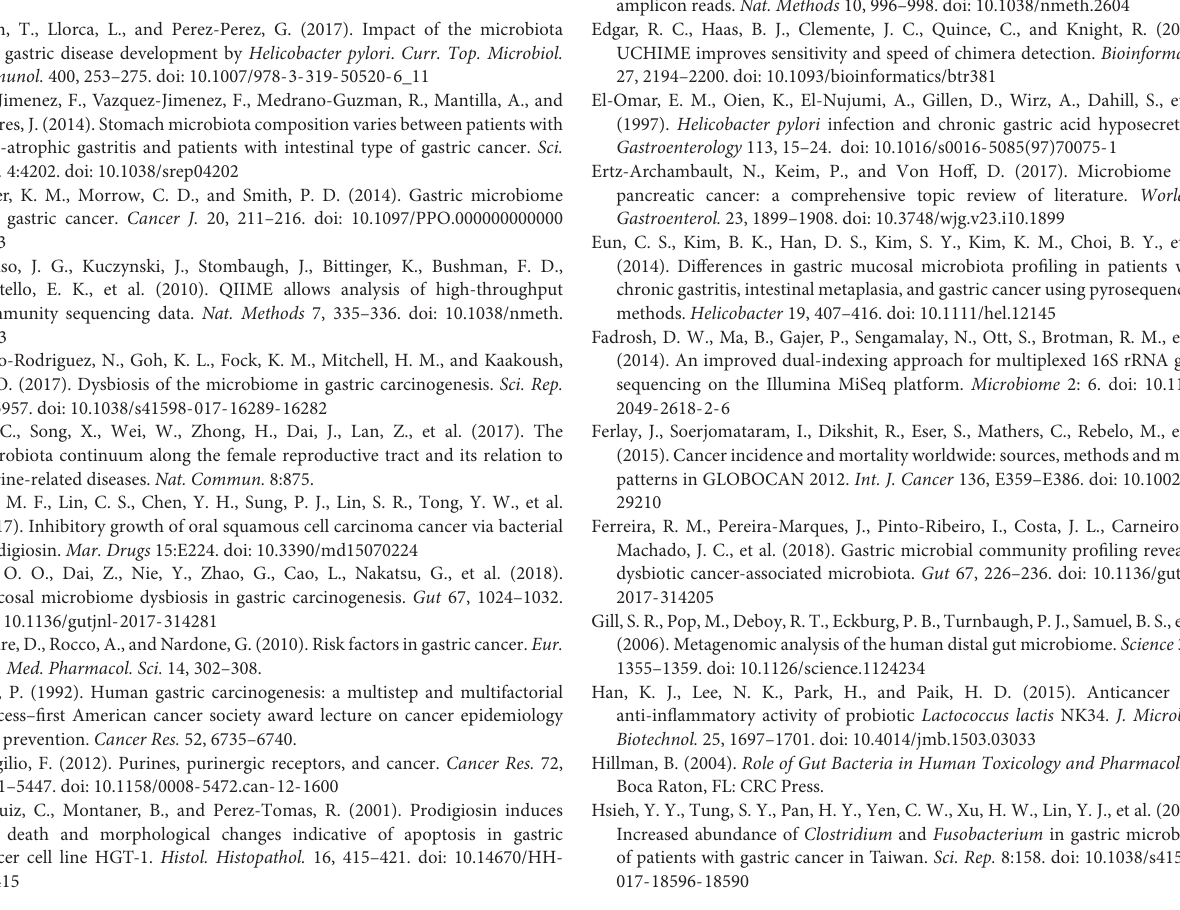
FIGURE S1 | Bacterial profiling plot of relative abundances of operational taxonomic units (OTUs) at the phylum level. FIGURE S2 | LEfSe analysis in non-cancer tissues with and without H. pylori colonization. Green indicates taxa enriched in H. pylori positive group and red indicates taxa enriched in H. pylori negative group. FIGURE S3 | Differences in functional compositions between the cancer and non-cancer groups by LEfSe analysis (LDA scores > 2.0). Green indicates functions enriched in cancer group and red indicates functions enriched in non-cancer group. C, cancer group; N, non-cancer group. TABLE S1 | OUT abundance table. TABLE S2 | Sequencing data. TABLE S3 | Association between alpha diversity indices of microbiota in cancerous tissues and GC risk factors.